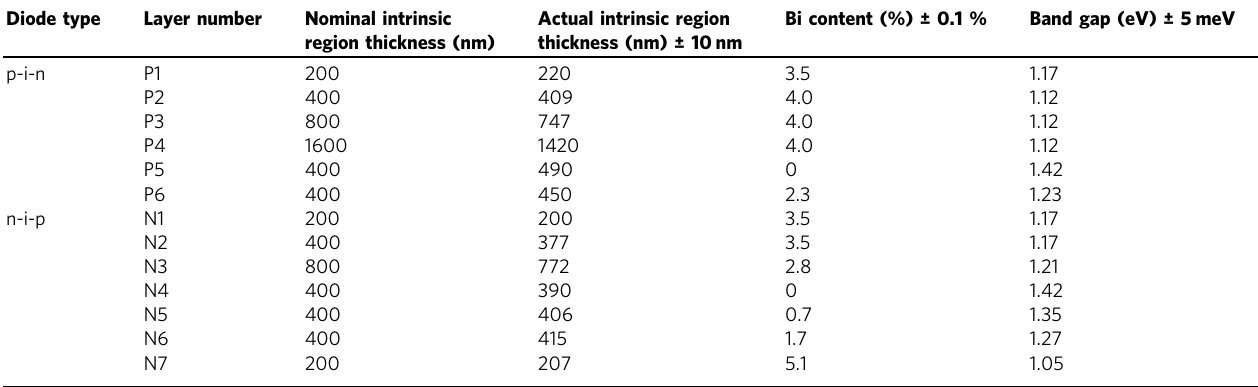
Table 1 Experimental layer